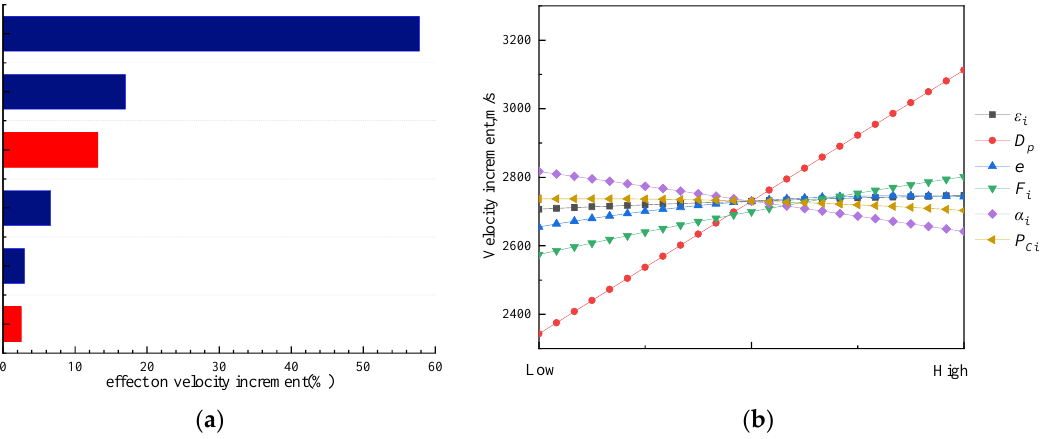
Figure 18. Parametric analysis of design variables to velocity increment. ( a ) Pareto diagram; ( b ) main effect plot.